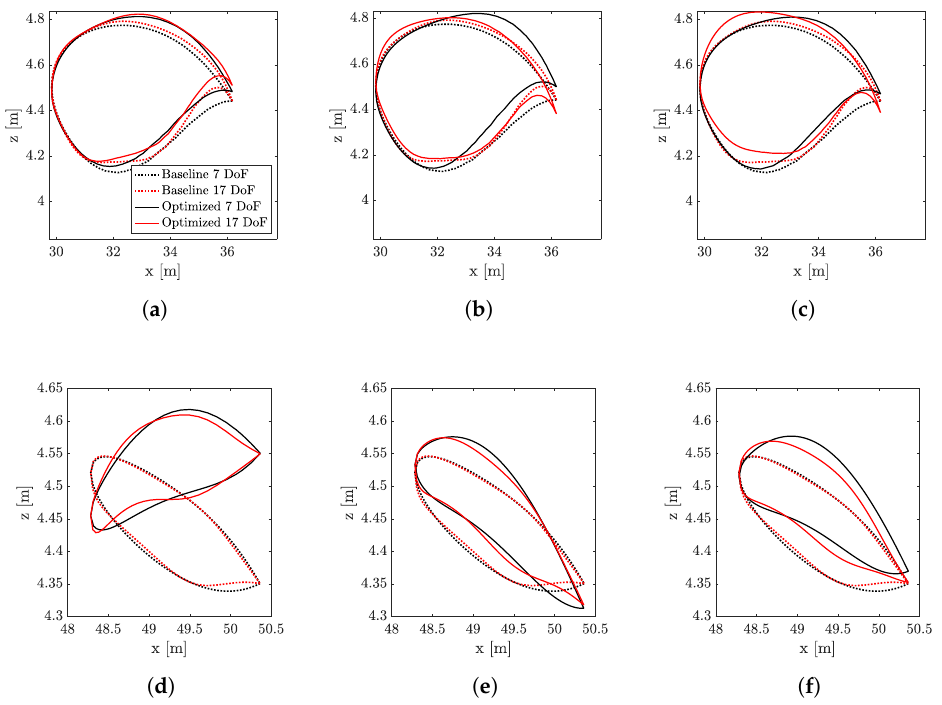
Figure 14. Baseline and optimized airfoil shapes, where aeroelastic cases show the undeflected jig shapes. ( a ) Yehudi, rigid; ( b ) Yehudi, aeroelastic; ( c ) Yehudi, aeroelastic with sizing; ( d ) Tip, rigid; ( e ) Tip, aeroelastic; ( f ) Tip, aeroelastic with